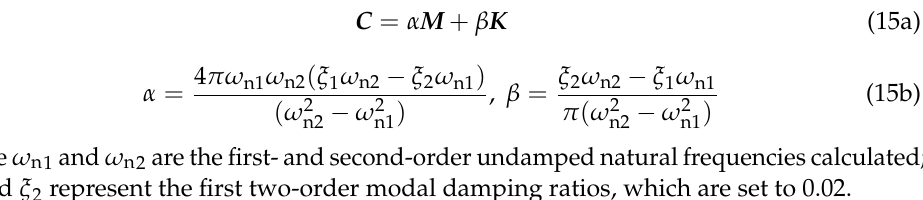
Figure 4. Then, based on the rotor dynamics theory, the dynamic governing equation with 72 DOFs describing the rotor motion induced by blade off is deduced as